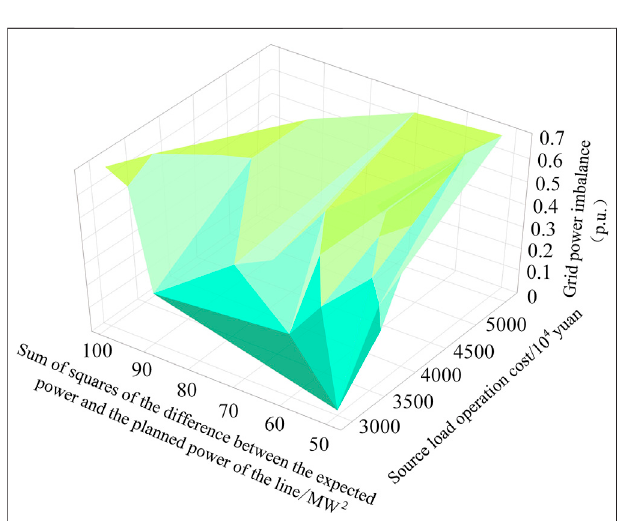
FIGURE 4 | Variation curves of power supply in the power grid without energy storage device.